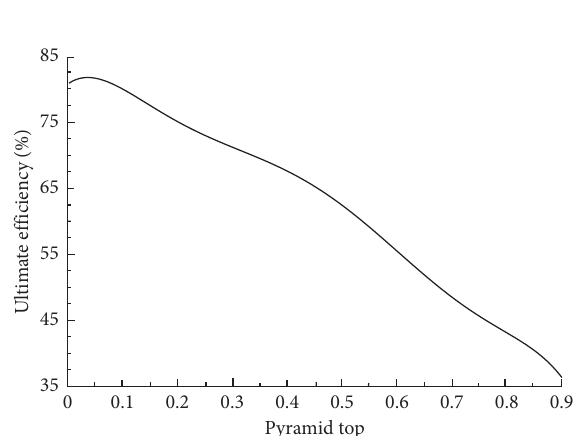
Int ) in relation to